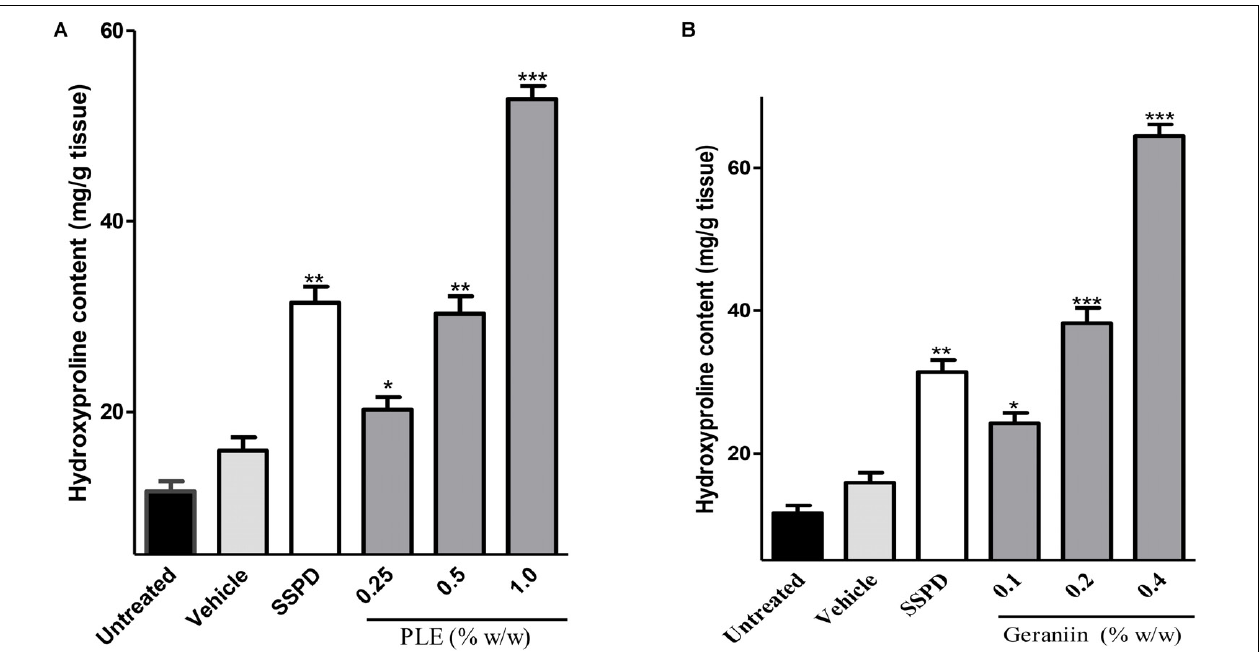
FIGURE 4 | Influence of PLE (A) and geraniin (B) treatment on hydroxyproline production in excised wound tissues. Hydroxyproline content was determined using acid hydrolysate of excised wound tissue on day 7 post injury. Excised wounds were treated with PLE (0.25, 0.5, and 1% w/w), geraniin (0.1, 0.2, and 0.4% w/w), silver sulphadiazine, and cream only. PLE, aqueous extract of the aerial parts of P. muellerianus . Vehicle group was treated with aqueous cream only. SSPD, 1% w/w silver sulphadiazine-treated wounds. Values are mean ± SEM, n = 5. ∗∗∗ p < 0.001; ∗∗ p < 0.01; ∗ p < 0.05 compared to untreated wound tissues (One-way ANOVA followed by Dunnet’s post hoc